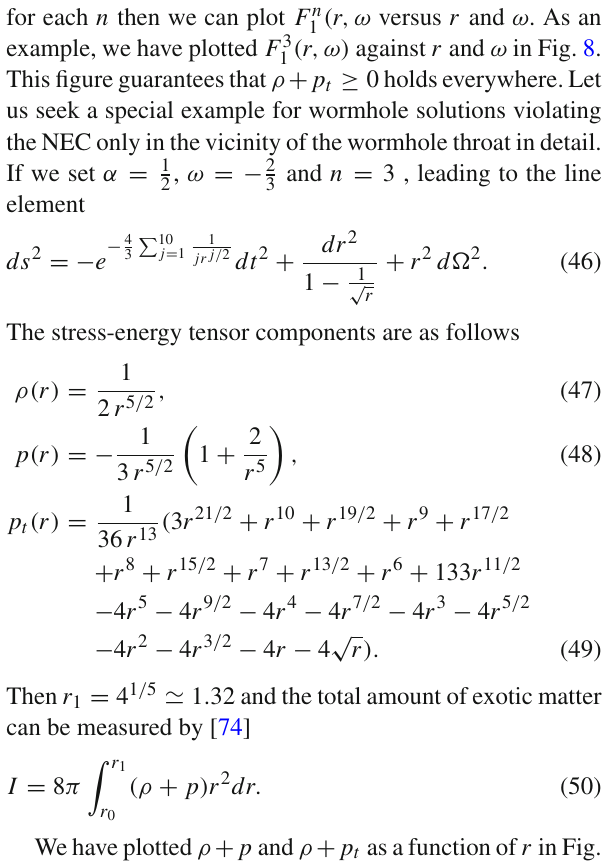
Fig. 6 The plot depicts the function r 1 ( n ,ω,α) as a function of α and n for ω = − 1 . It is clear that r 1 increases as α or n decreases. See the 2 text for details